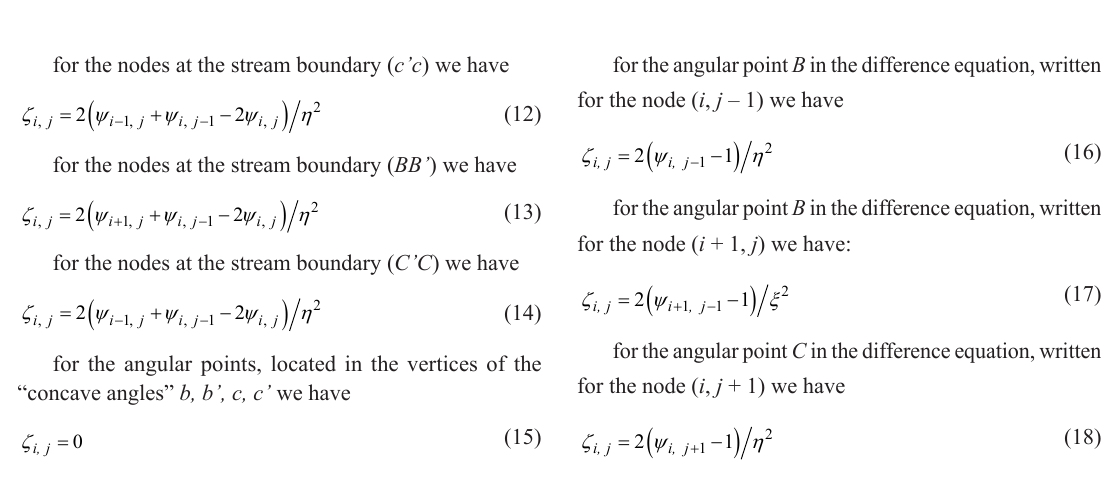
Fig. 4. CFD-derived dimensionless v-component of flow velocity w (a), dimensionless flow velocity w (b), dimensional punching pressure (c), and dimensional tangential stress (d), derived for ECMAE of plasticine viscous fluid through the U-shaped slanted ECMAE die, where the entrance (aA) and the exit (dD) are at the